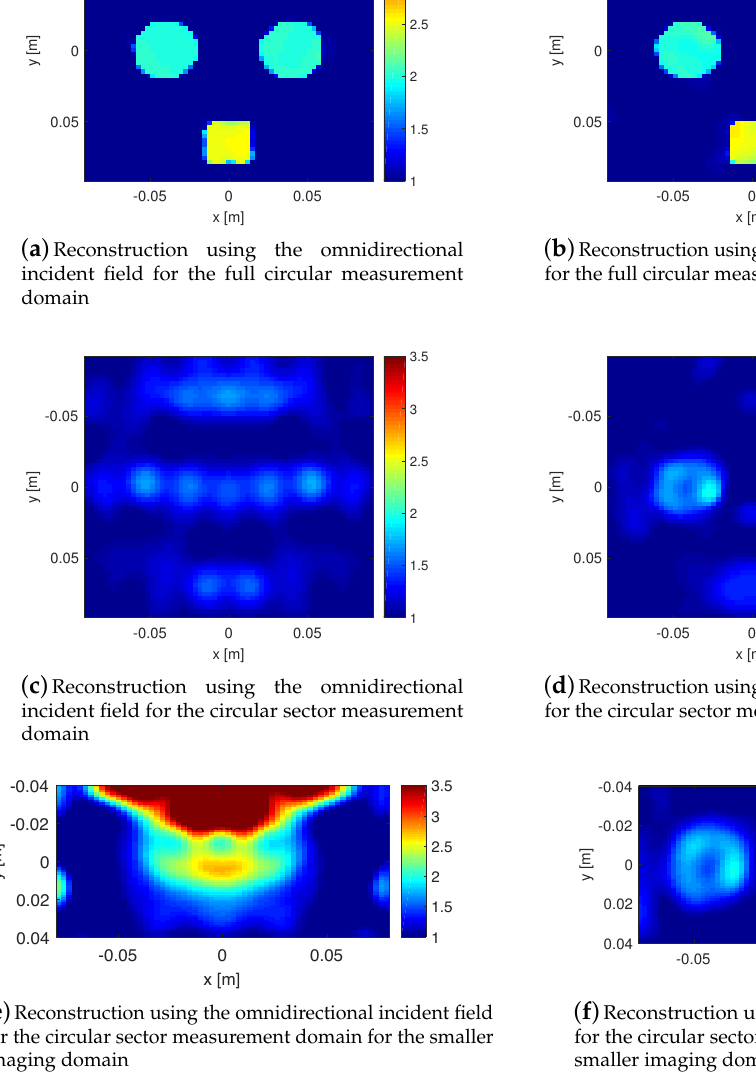
Figure 4. ( a , b ) represent the inversion of the data collected on the full circular measurement domain for two cases: omnidirectional and focused incident fields, respectively; ( c , d ) represent the inversion of the data collected on the circular sector measurement domain for two cases: omnidirectional and focused incident fields, respectively; ( e , f ) represent the inversion of the data collected on the circular sector measurement domain for two cases, omnidirectional and focused incident fields, respectively, with the smaller imaging domain that only includes the OI, and not the undesired